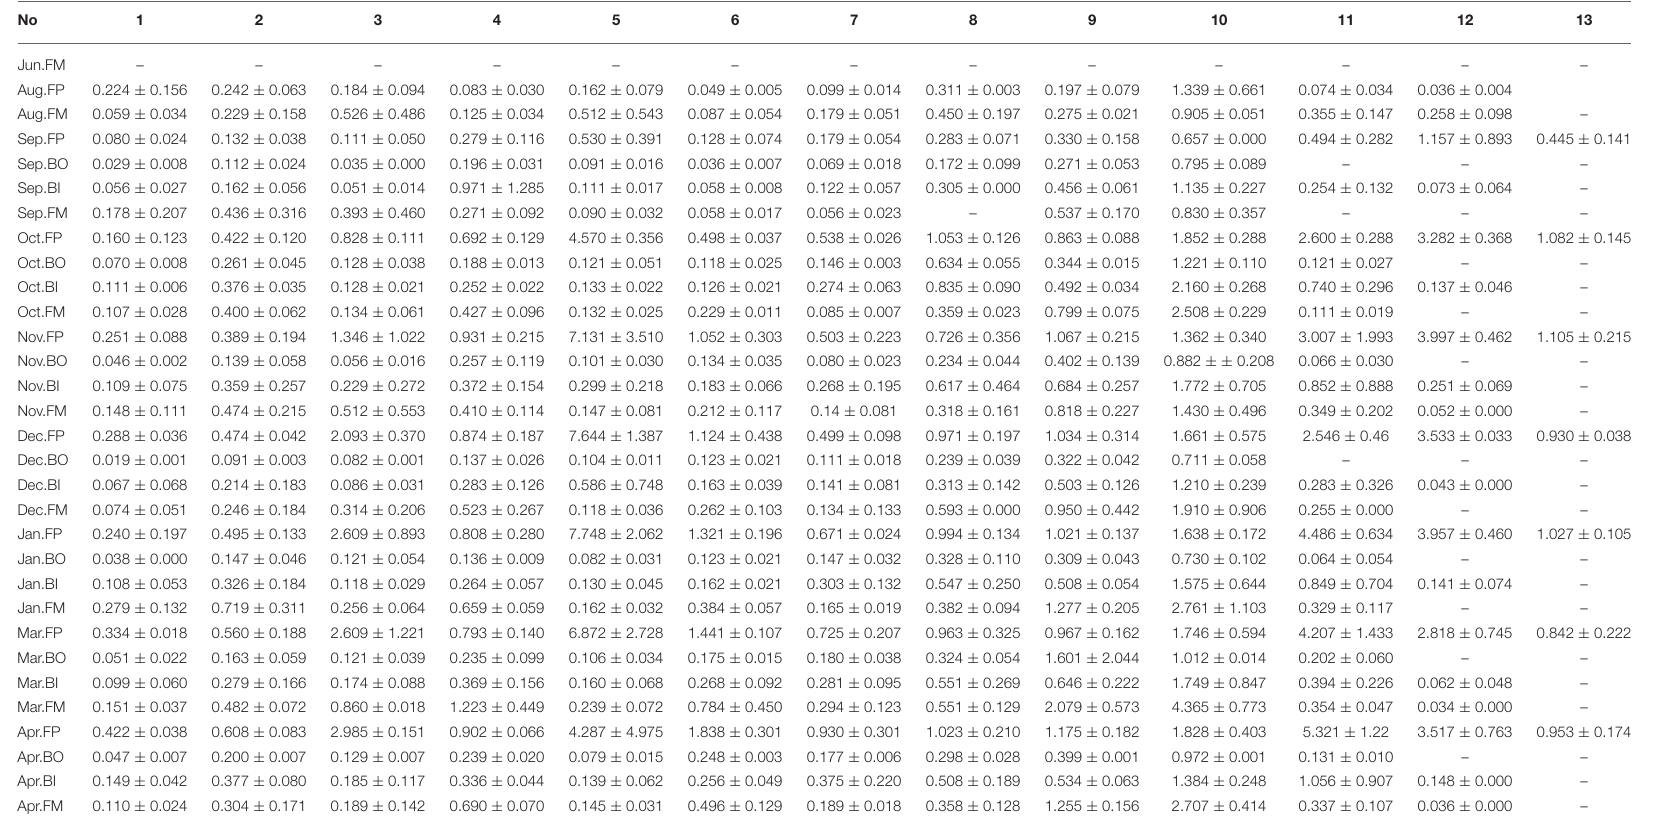
TABLE 3 | The content levels (mg/g) of 13 triterpenoid acids in four parts of Fushen at the nine growth periods.